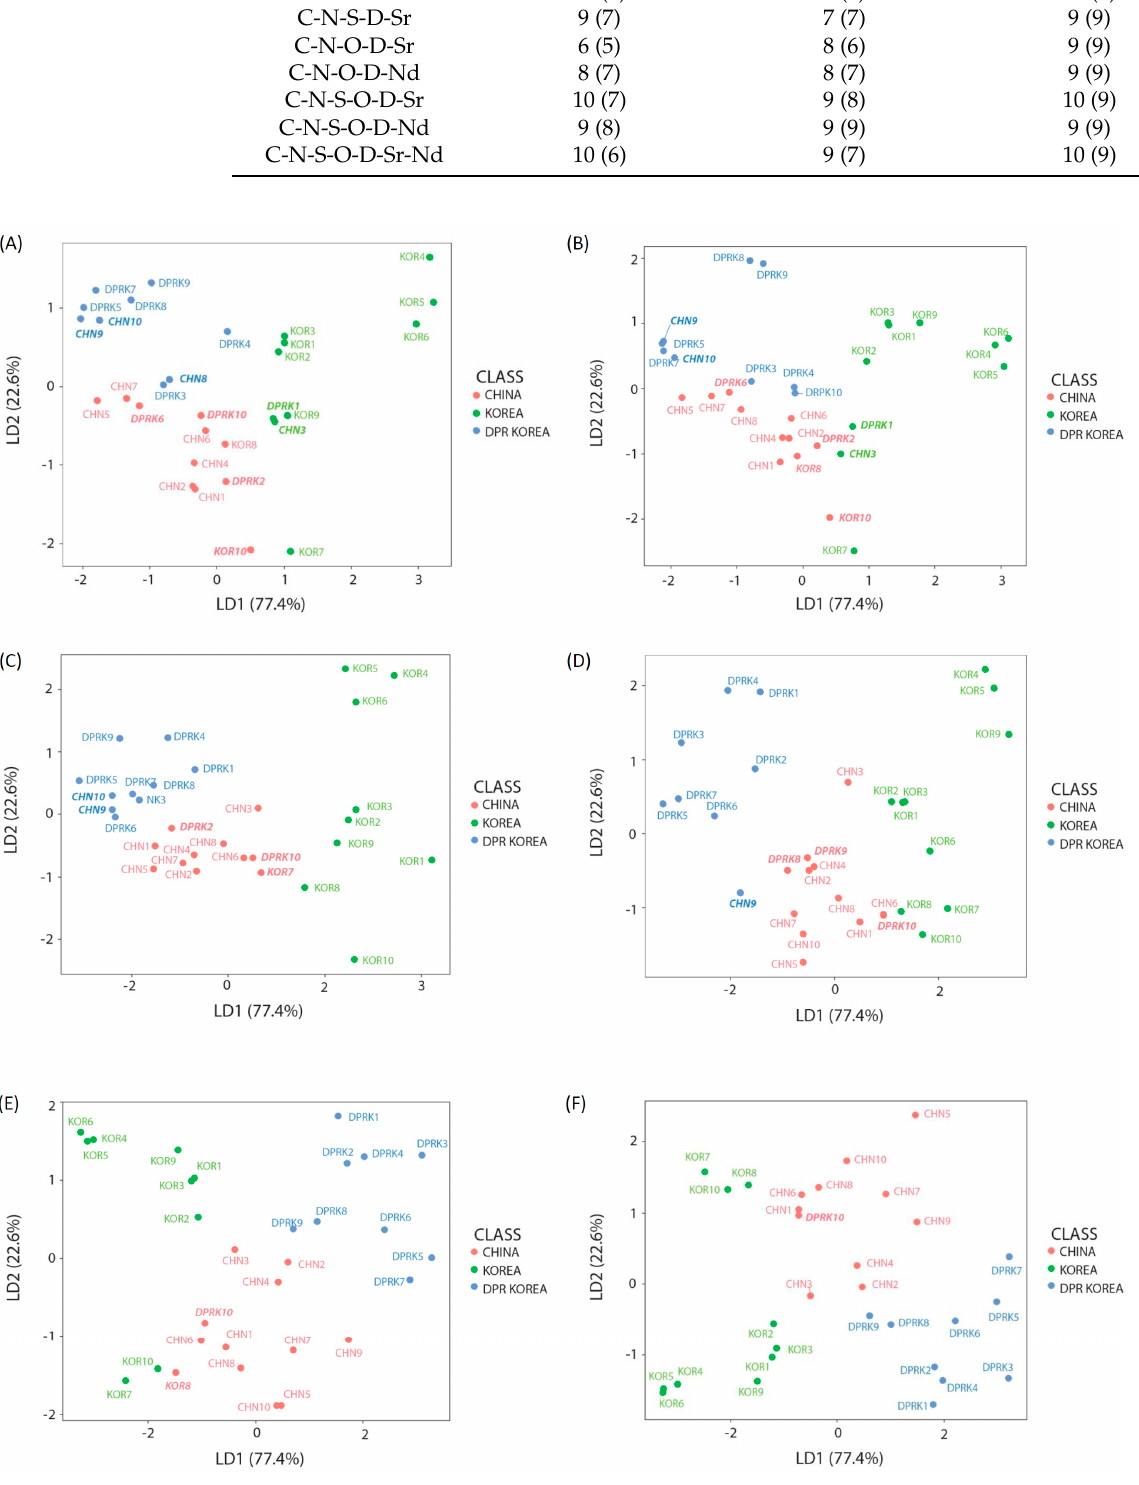
Figure 2. Manila clams from three countries grouped according to LDA findings of combined basic stable isotopes. ( A ) δ 13 C and δ 15 N-; ( B )- δ 13 C, δ 15 N, and δ 18 O-; ( C ) δ 13 C, δ 15 N, and δ D-; ( D ) δ 13 C, δ 15 N, and δ 3 S-; ( E ) δ 13 C, δ 15 N, δ 34 S, and δ 18 O; and ( F ) δ 13 C, δ 15 N, δ 34 S, δ 18 O, and Sr/Sr. Bold italic, which is shown as a different color for same country, indicates samples that have not been classified as the original provenance.